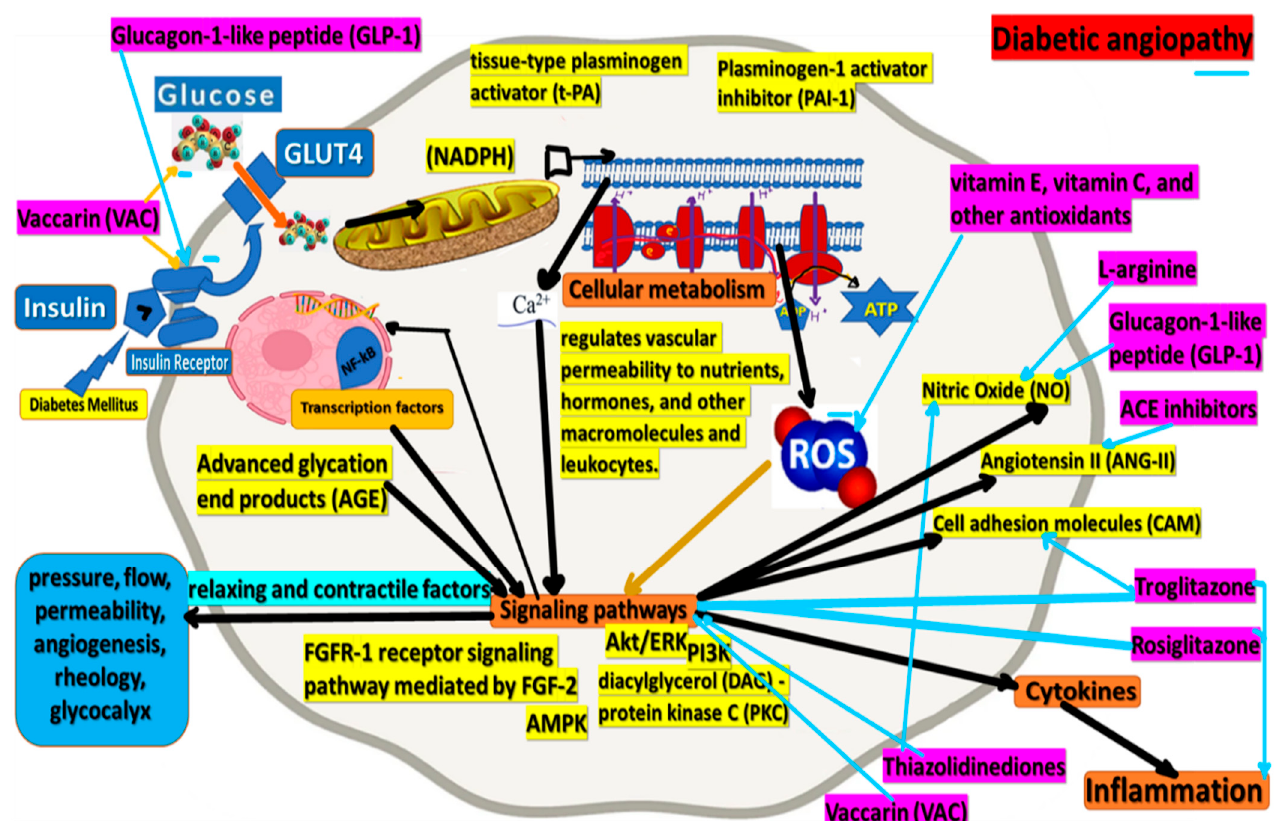
Figure 3. Molecular approaches of therapeutic interventions proposed to improve endothelial function in patients with DM.